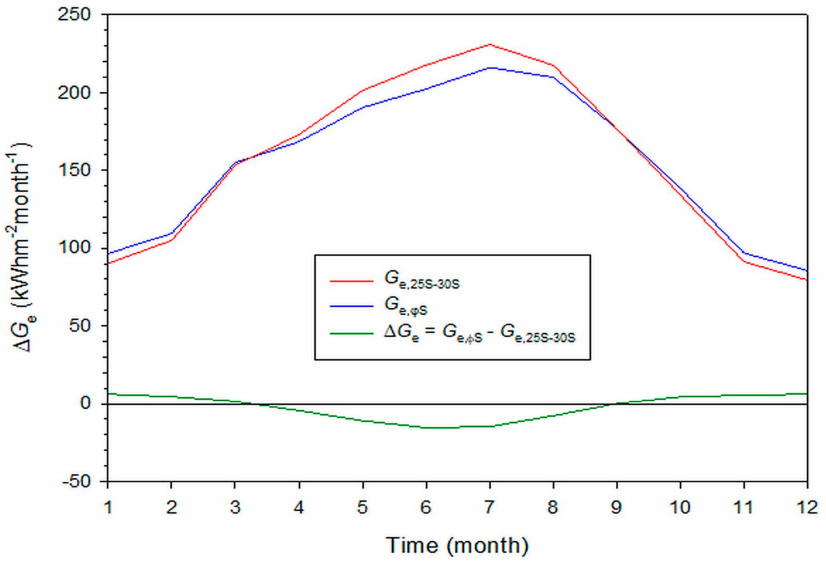
Figure 8. Intra-annual variation of the monthly mean G e ,25S-30S and G e, ϕ S sums and their monthly